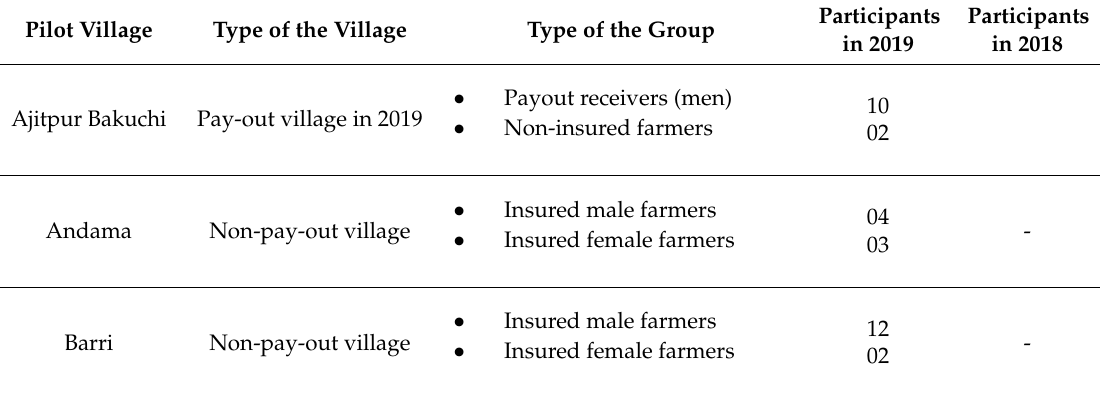
Table 3. Details of Focus group discussions held in Muza ff arpur District, Bihar in 2018 and 2019. Pilot